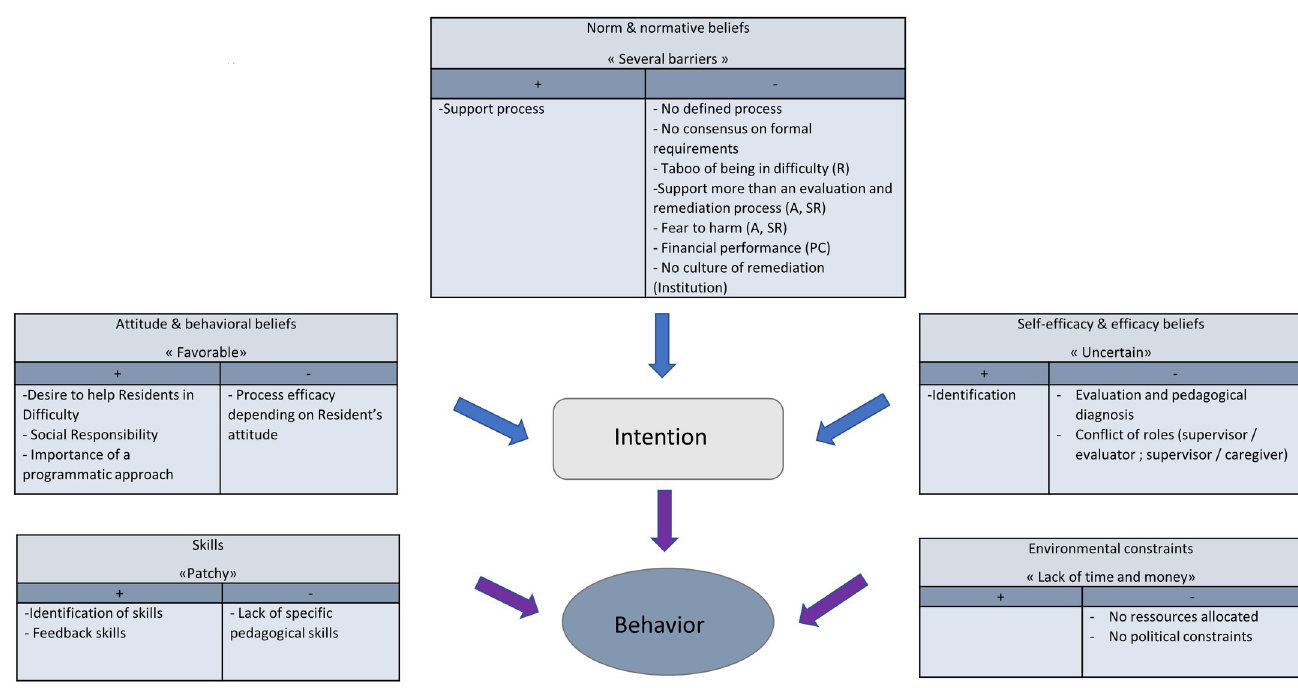
Fig 2. Summary of results integrated in the Fishbein’s conceptual framework and classified by their favorable or unfavorable potentialities regarding a future implementation of a remediation program for residents in difficulty.